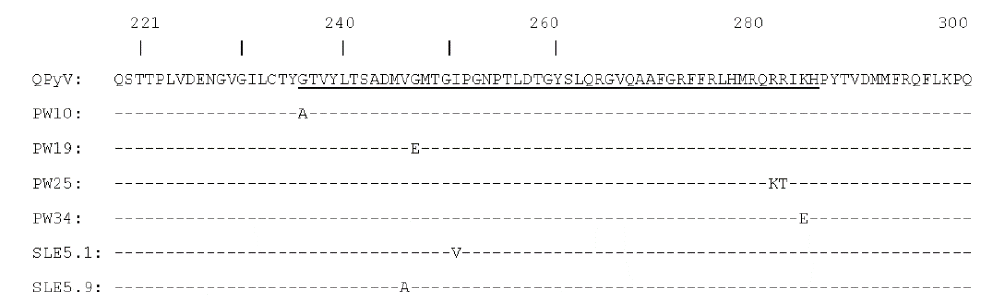
Figure 2. Amino acid sequence alignment of the QPyV VP1 fragment (residues 221−304). The published sequence (BK010702) is given at the top. A hyphen indicates an identical amino acid. The sequence corresponding to the HI-loop in HPyV6 and HPyV7 VP1 is underlined. Isolates with silent mutations are not shown.